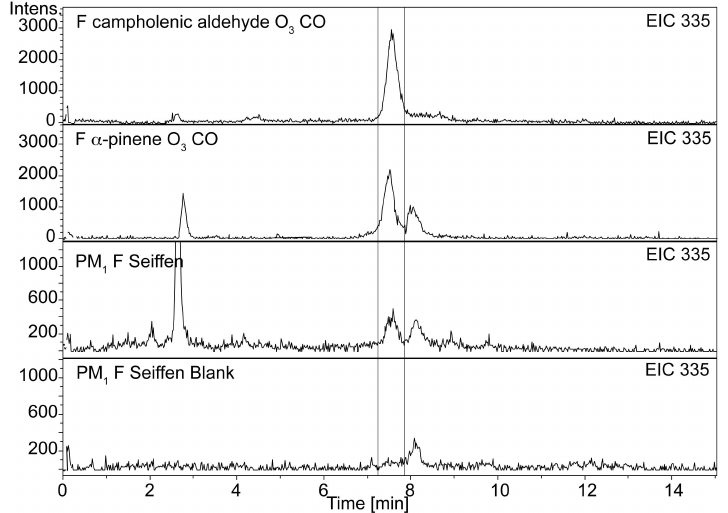
Fig. 4. Extracted ion chromatograms (EICs) of a mono-DNPH-derivatised compound ( m / z 335) detected in campholenic aldehyde ozonol- ysis, α -pinene ozonolysis and an ambient filter sample (Seiffen, Germany).